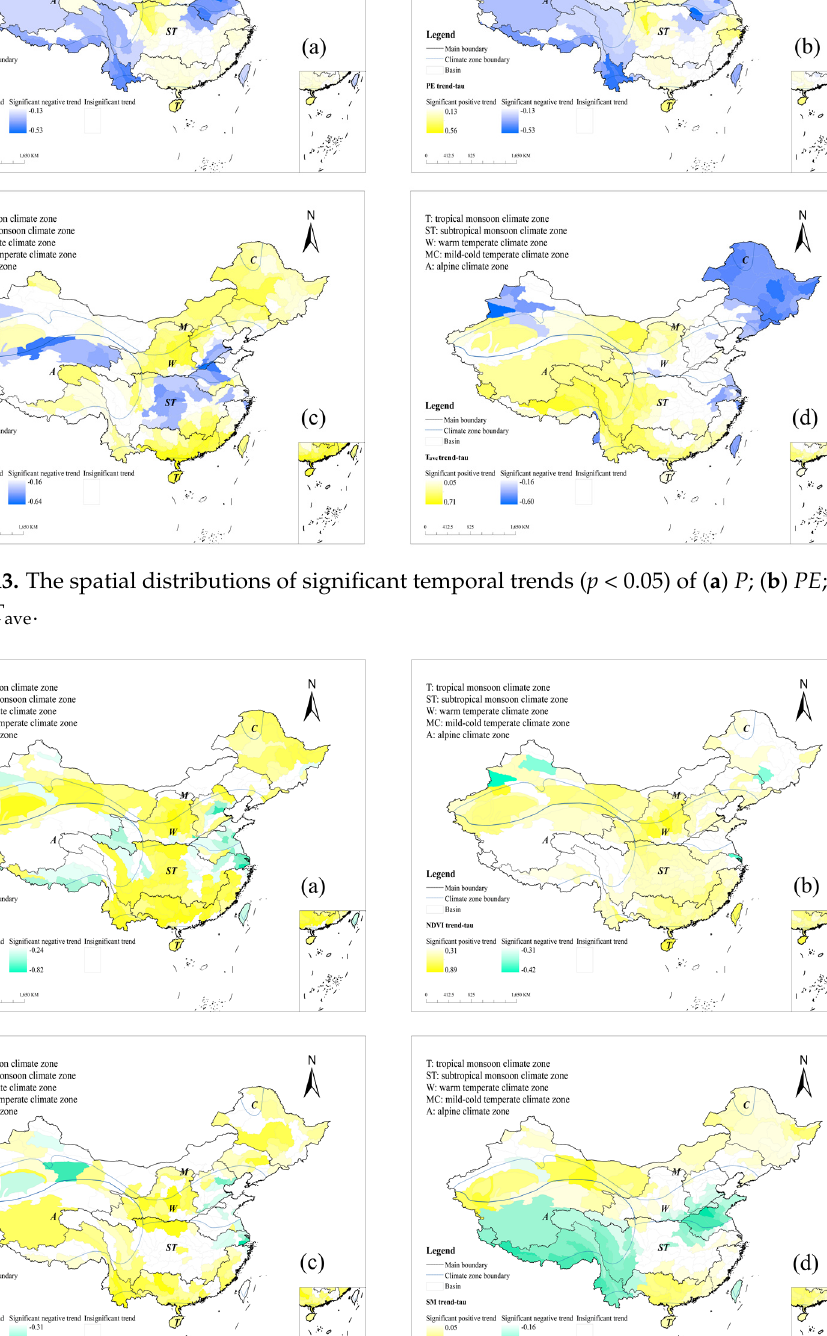
Figure A4. The spatial distributions of significant change trends ( p < 0.05) of ( a ) LAI; ( b ) NDVI ; ( c ) VFC ; and ( d ) SM. ( c ) VFC ; and ( d )